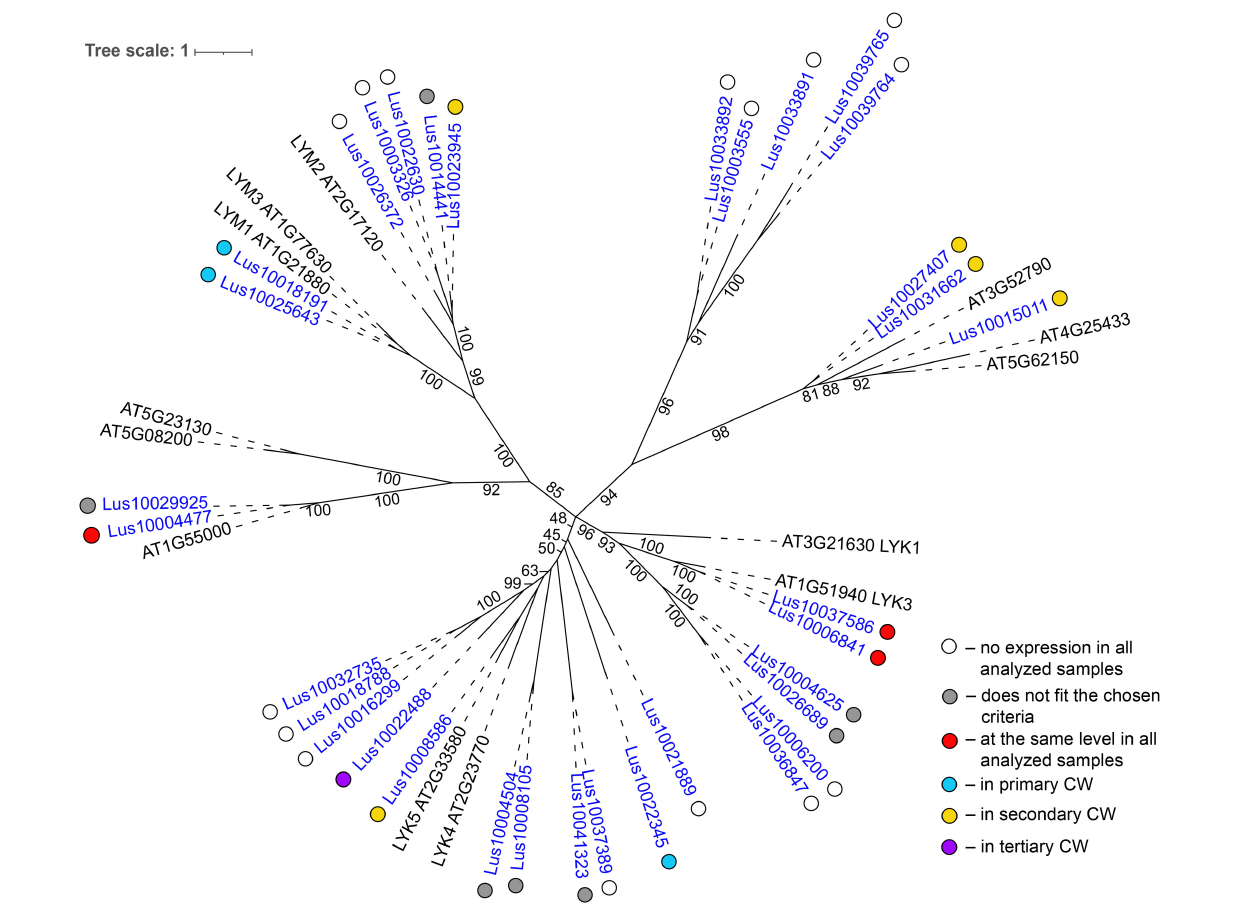
FIGURE 7 | Phylogenetic dendrogram of LysM (PF01453) lectin family members of Arabidopsis thaliana and Linum usitatissimum . The A. thaliana gene names are given in black font; additional gene names are given according to Shinya et al. (2012) and Wan et al. (2012). The L. usitatissimum gene names are given in dark blue font. The different colored dots next to L. usitatissimum gene names indicate genes with different expression patterns. The criteria used for different expression pattern identification as follow: red, the mean values of tau-score < 0.15 across all samples; light blue, DEGs upregulated in samples with primary CW; yellow, DEGs upregulated in samples with secondary CW; purple dots, DEGs upregulated in samples with tertiary CW. Flax genes with red, light blue, yellow, and purple dots are listed in Tables 2–5 , respectively. White dots indicate genes that are not expressed in the analyzed flax samples, and gray dots indicate genes where the expression does not fit the chosen criteria for a certain expression pattern (expression values for these genes are given in Supplementary File 3 ). Numbers indicate the ultrafast bootstrap support values for some branches. Abbreviations: DEGs, differentially expressed genes, a pairwise comparison log 2 FC ≥ 1; padj ≥ 0.01, CW, cell